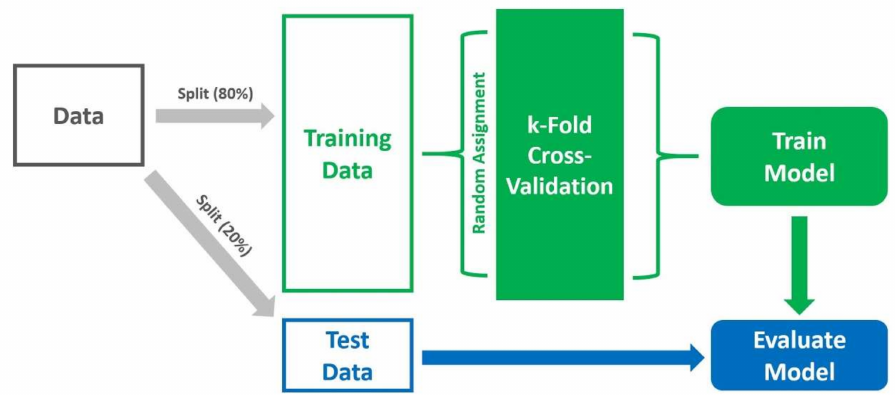
Figure 5. Validation policy: k-fold cross